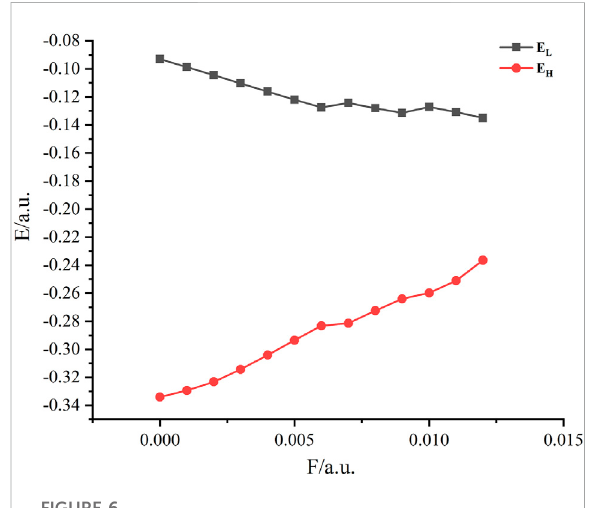
FIGURE 6 Variation of frontier orbital energy of the plasma-modi fi ed polyimide with electric fi eld.